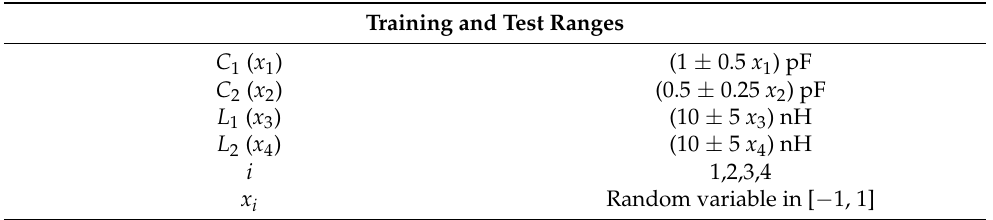
Table 2. High-speed interconnect link parameters for the training and test